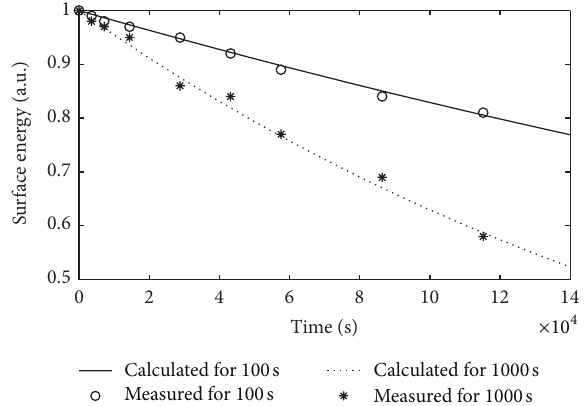
Figure 4: Normalized surface energy (𝑊/𝑊 𝑚 ) variation of PI exposed to DBD in SF 6 medium for 100s and 1000 s (𝑊 100 𝑚 = 0.122 J / m 2 , 𝑊 1000 𝑚